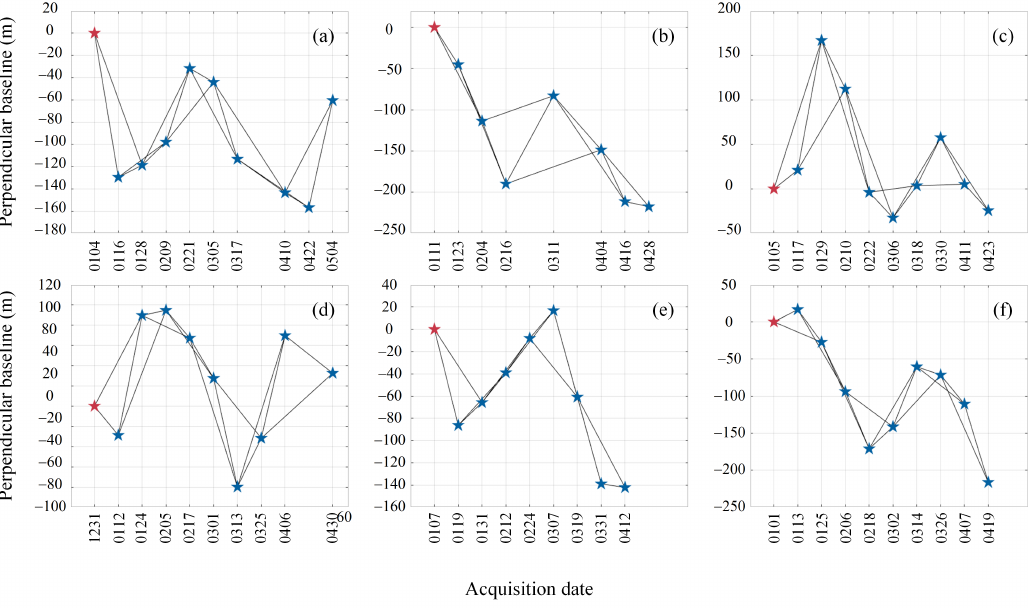
Figure A1. Perpendicular and temporal baselines of selected interferometric pairs. The red star de- fines the master image, while the blue stars are slave images: ( a ) 2019 ascending, ( b ) 2020 descending, ( c ) 2021 ascending, ( d ) 2019 descending, ( e ) 2020 ascending, and ( f ) 2021 descending.